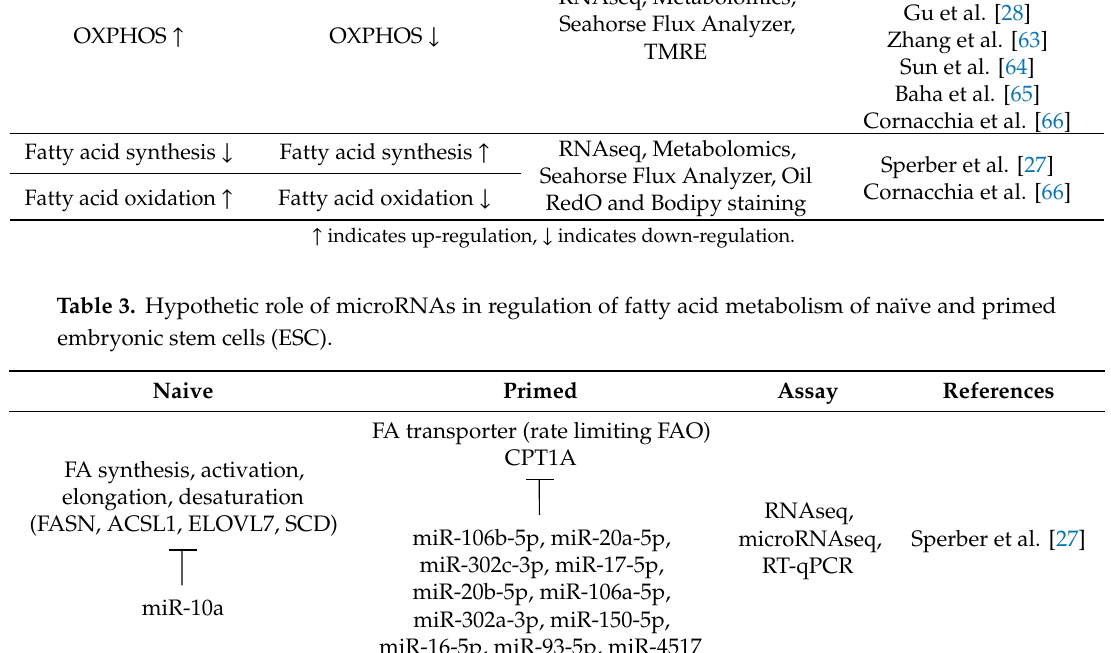
Figure 3. The polyamine pathway is dysregulated in naïve to primed transition: ( A ) Ornithine is converted to polyamines (spermine and spermidine) by the rate limiting enzyme ornithine decarboxylase (ODC1). ODC1 is consistently up-regulated in the naïve state, and its microRNA regulator, miR-218-bp, is lower in the naïve state. Each rectangle box is a metabolite; each arrow is a reaction. Red means higher abundance in naïve state; blue means lower abundance in naïve state. “--|” (T-bar) indicates repression of ODC1 by miR-218-5p. ( B ) Log2 fold change of ODC1 in three separate naïve vs. primed cell line comparisons. ( C ) ODC1 expression changes in monkey